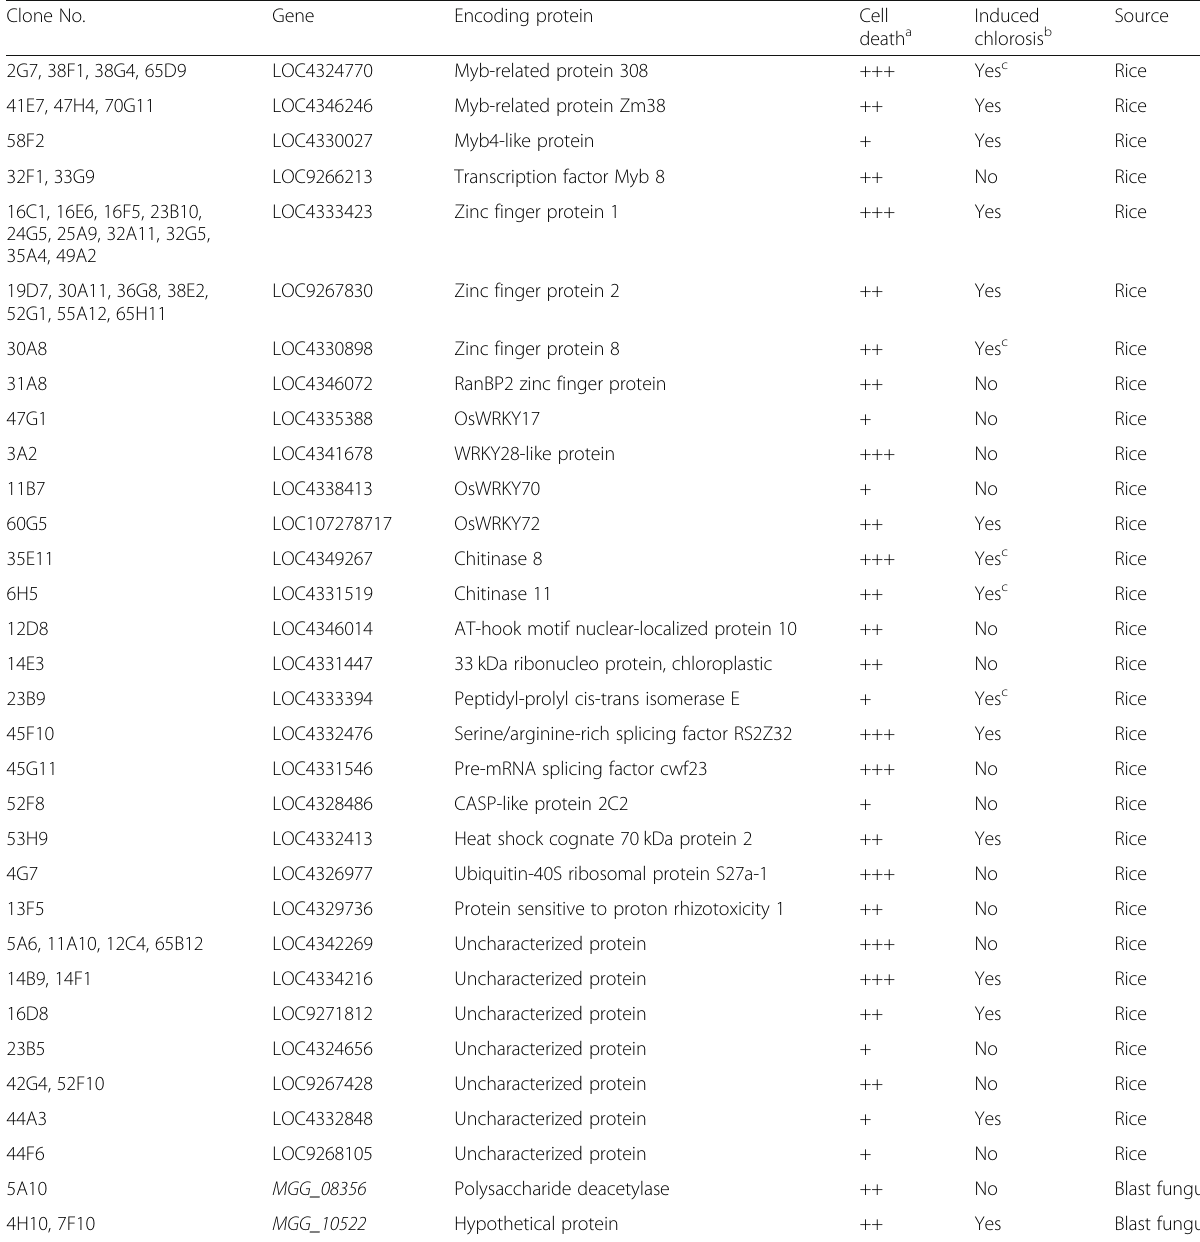
Table 2 Information of the candidate gene-encoding proteins Clone